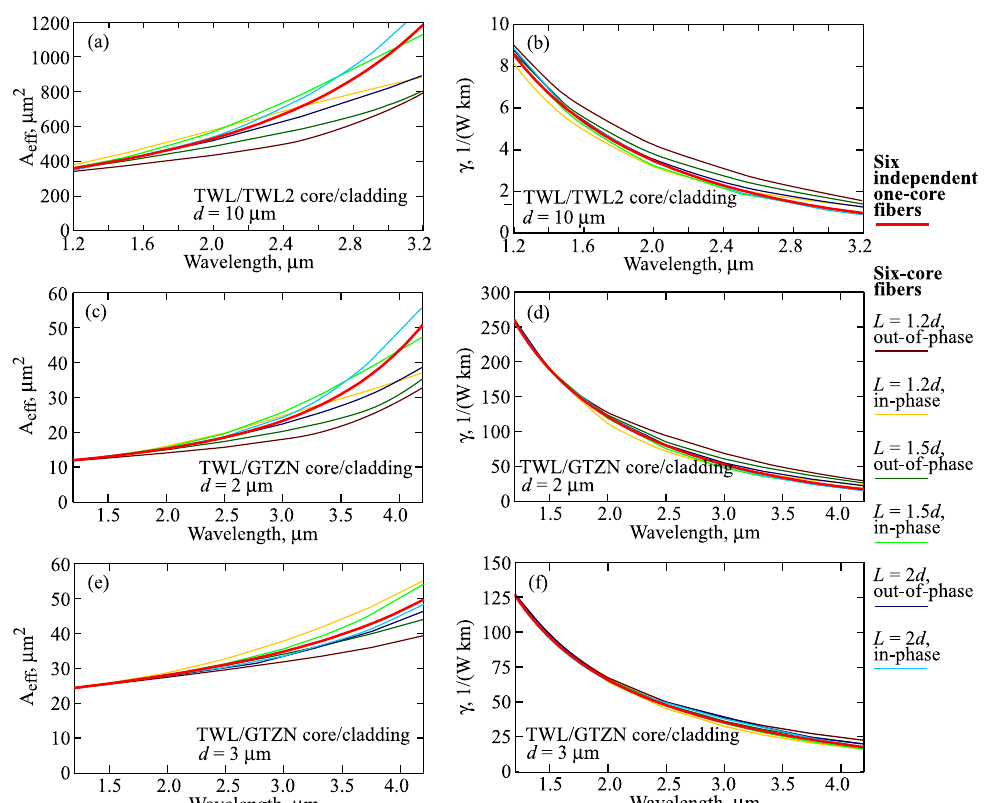
Figure 8. The calculated effective mode field areas (left column) and nonlinear Kerr coefficients (right column) for six-core fibers with different L / d ratios compared to the same for six independent cores for TWL/TWL2 core/cladding with d = 10 µ m ( a , b ); for TWL/GTZN core/cladding with d = 2 µ m ( c , d ); and for TWL/GTZN core/cladding with d = 3 µ m ( e , f